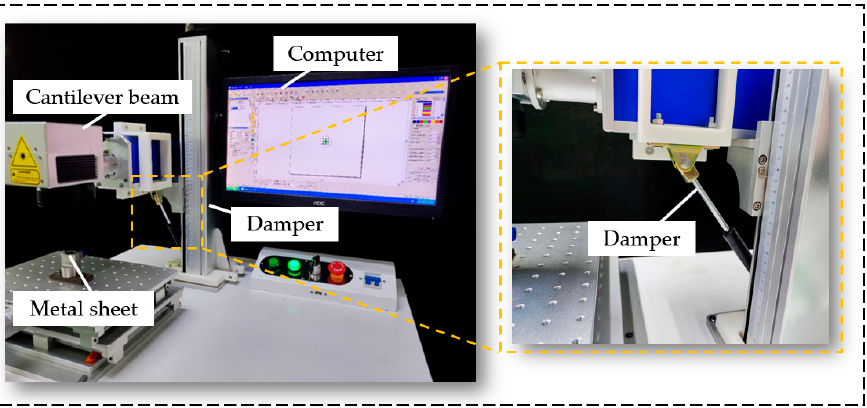
Figure 15. Schematic diagram of installing a damper on the laser